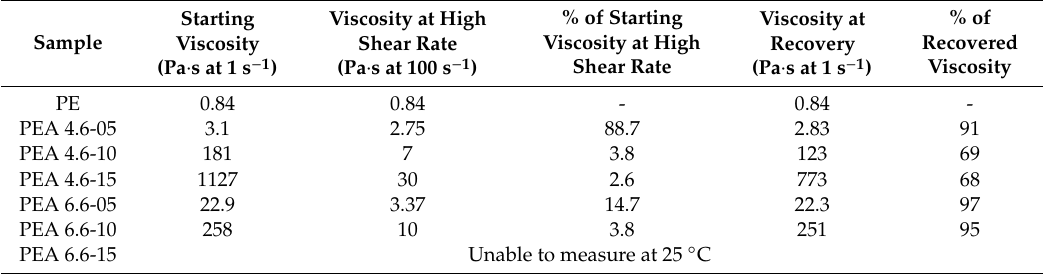
Figure 5. Viscosity experiment conducted to study the thixotropic behavior of the resins containing ( a ) 5 mol% amido diol and ( b ) 10 mol% and higher amounts of amido diol. Conditions: 3 min at 1 s − 1 , then 2 min at 100 s − 1 , finally 7 min at 1 s − 1 . Table 2. Viscosity values of the polymers at di ff erent shear rates and percentage of the initial viscosity recovered at the end of the